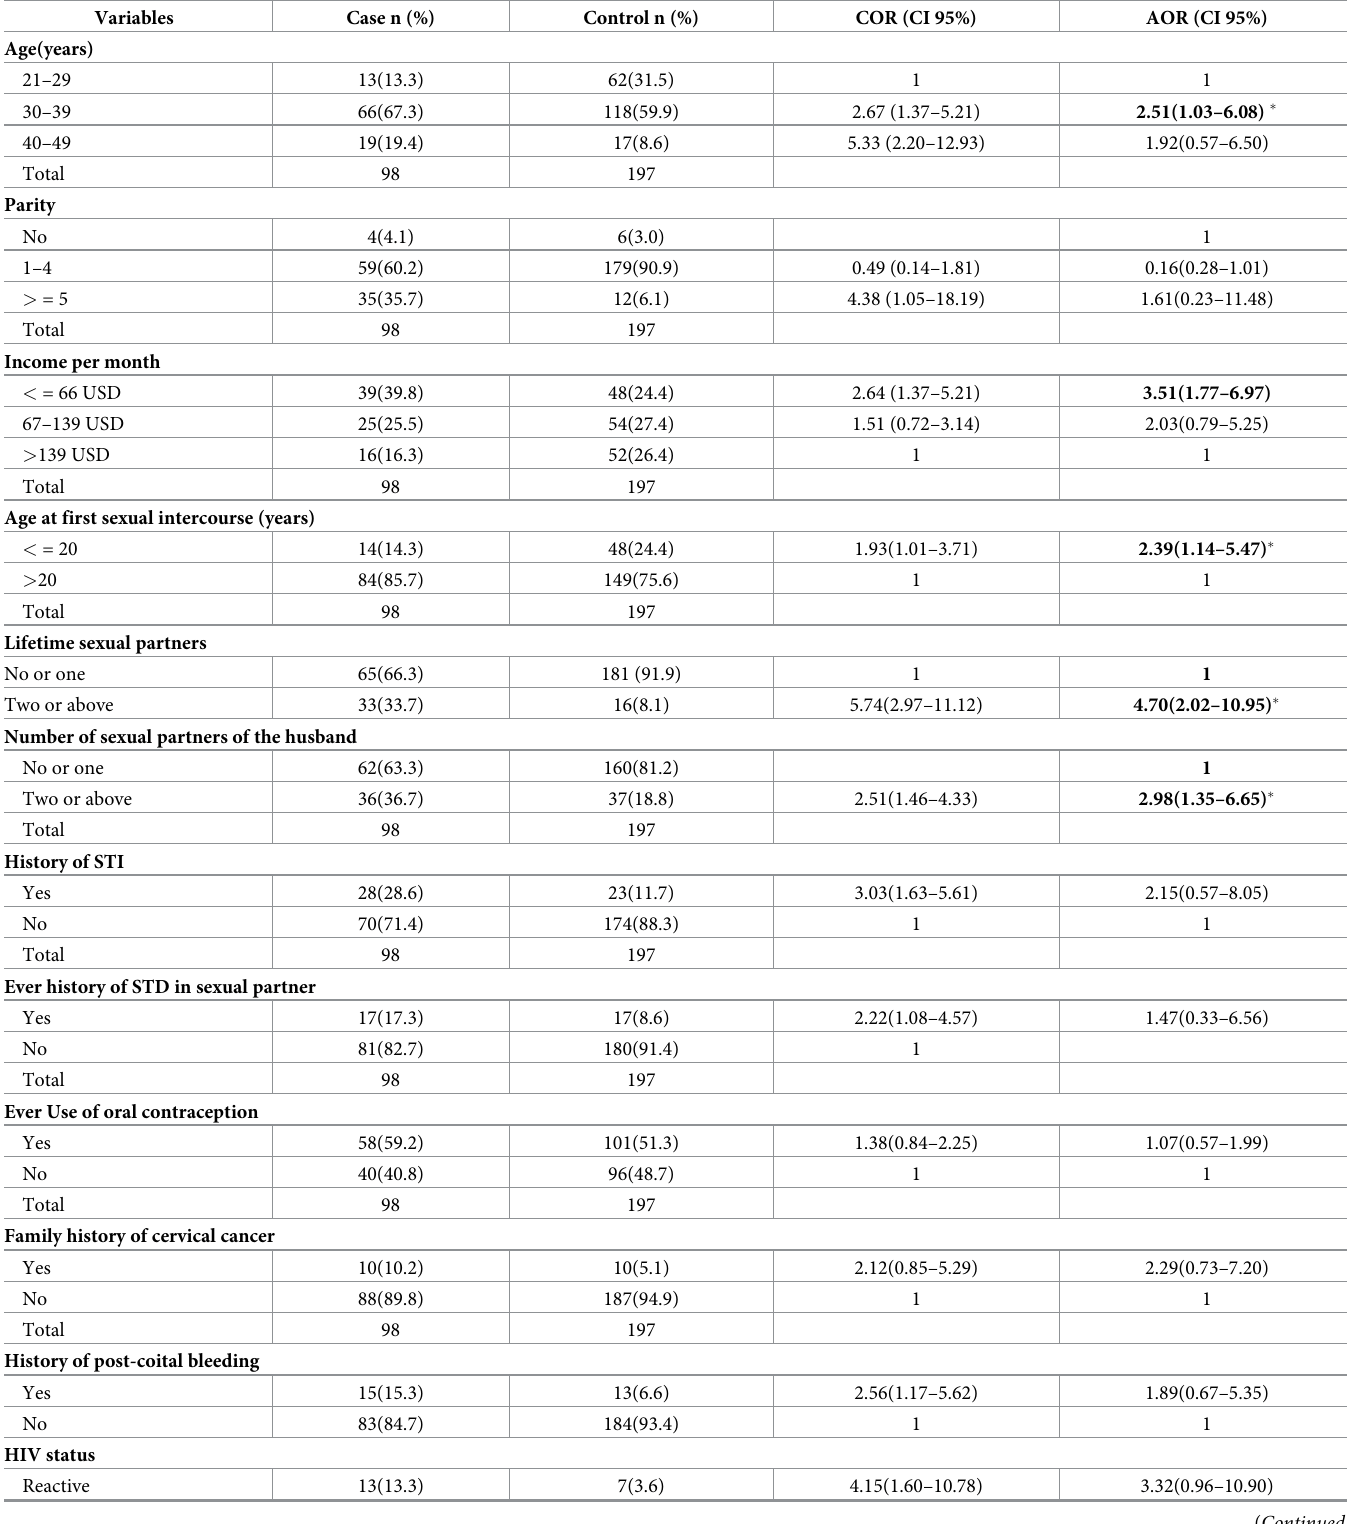
Table 4. A multivariate logistic regression on determinants of precancerous cervical lesion in south Ethiopia,